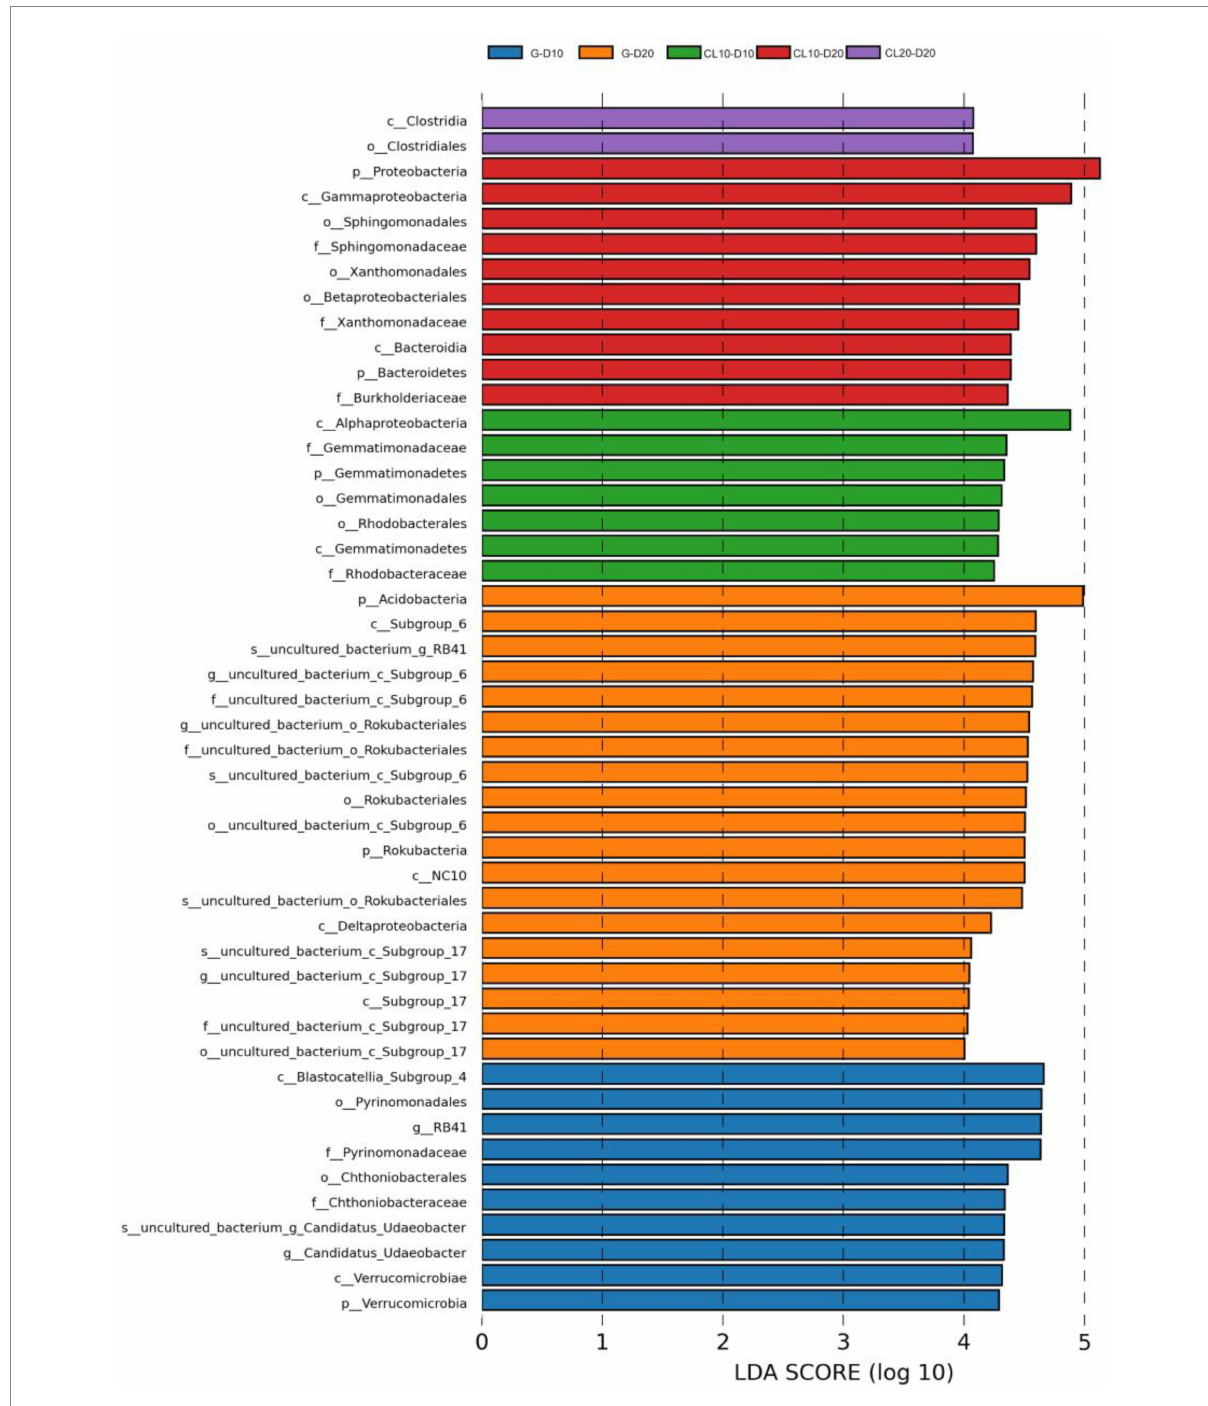
FIGURE 5 Lefse analysis of bacterial communities under different land use